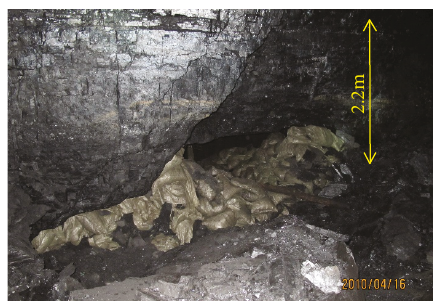
Figure 8: Roof caving in the No.1 abandoned tunnel.